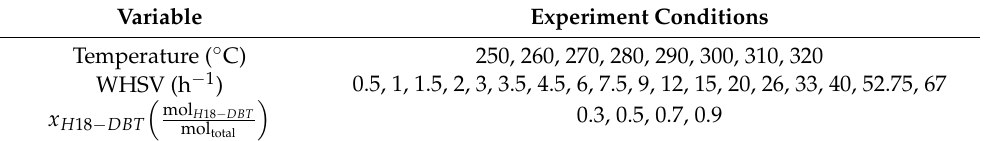
Table 7. Experimental